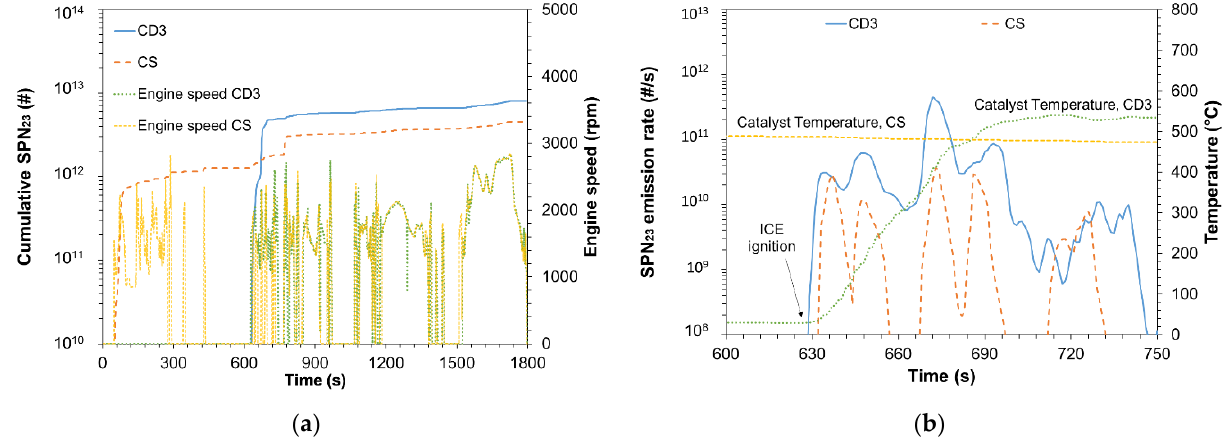
Figure 2. SPN 23 ( a ) cumulative (#) and ( b ) emission rate (#/s) emissions and of V2 over time, during the third charge-depleting (CD3) WLTC and the charge-sustaining cycle (CS) WLTC. During CD3, ICE switched on after ~630 s and powered the vehicle (as already re- ported above) for total ~880 s. Cumulative SPN 23 steeply increased during the first 70 s after the cold start and ~4.8 × 10 12 # was emitted which corresponded to ~60% of the total cycle SPN 23 . Note that in the entire CS, the total SPN 23 emitted was 4.5 × 10 12 #. In order to put this result in the right context, considering the limit of 6 × 10 11 #/km, the SPN 23 during a WLTC could not overcome ~1.4 × 10 13 #. Thus, V2 emitted ~32% of the maximum cumu- lative SPN 23 (#) permitted during a WLTC in 70 s, covering a distance of 650 m. Whilst form in this case.